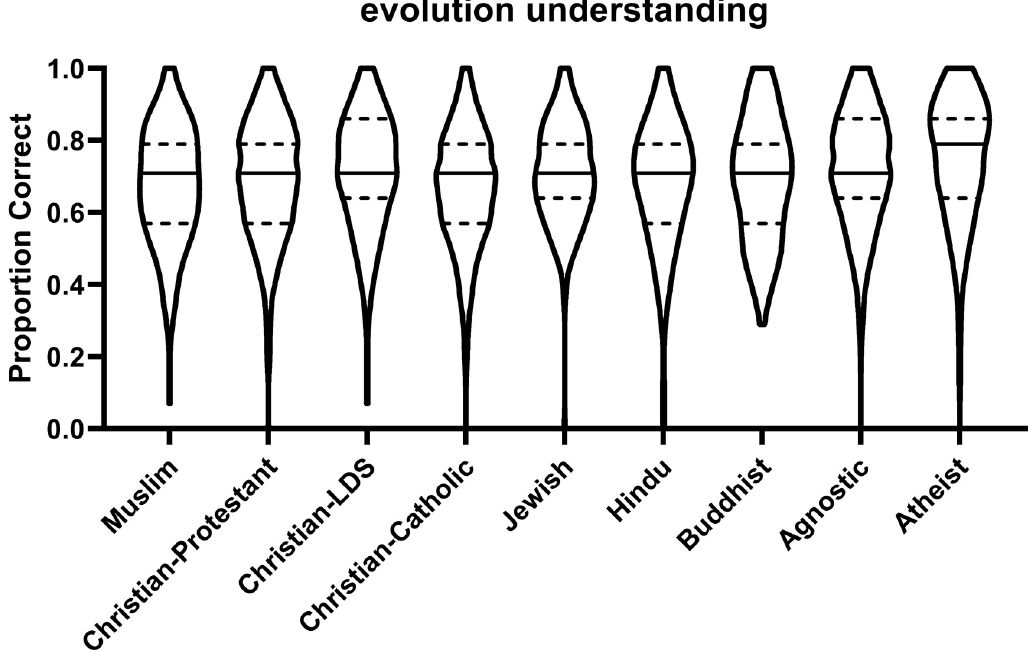
Fig 1. Evolution understanding. Violin plots of proportion of correct answers on a test of evolution understanding disaggregated by religious affiliation. The violin shapes are the densities of the data at each point on the y-axis. The solid black lines are the medians, and the top and bottom broken lines are the 75 th and 25 th percentiles of the data.